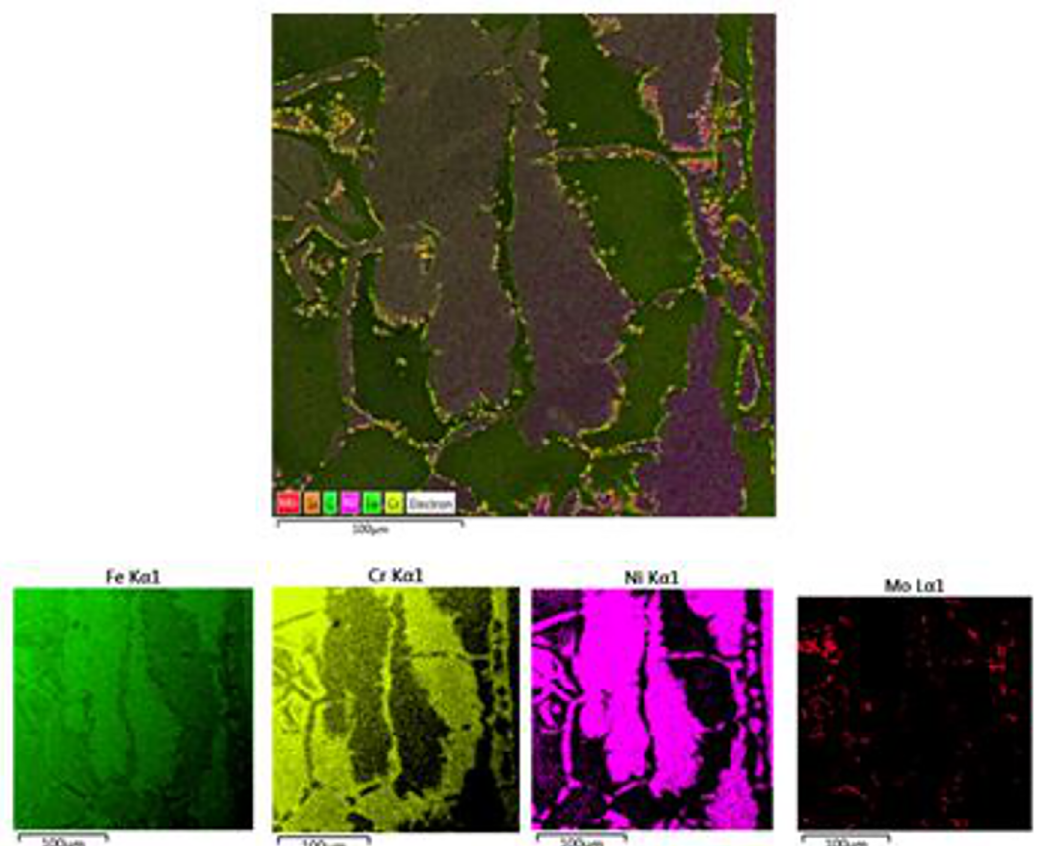
Figure 3. EDS compositional mapping for sample aged at 830C for 30